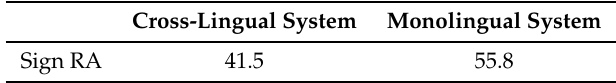
Table 10. Sign language RA on the DSGS database of the KL-HMM system trained with TSL HospiSign subunits posterior probabilities in the multilingual case and DSGS subunits in the monolingual one.